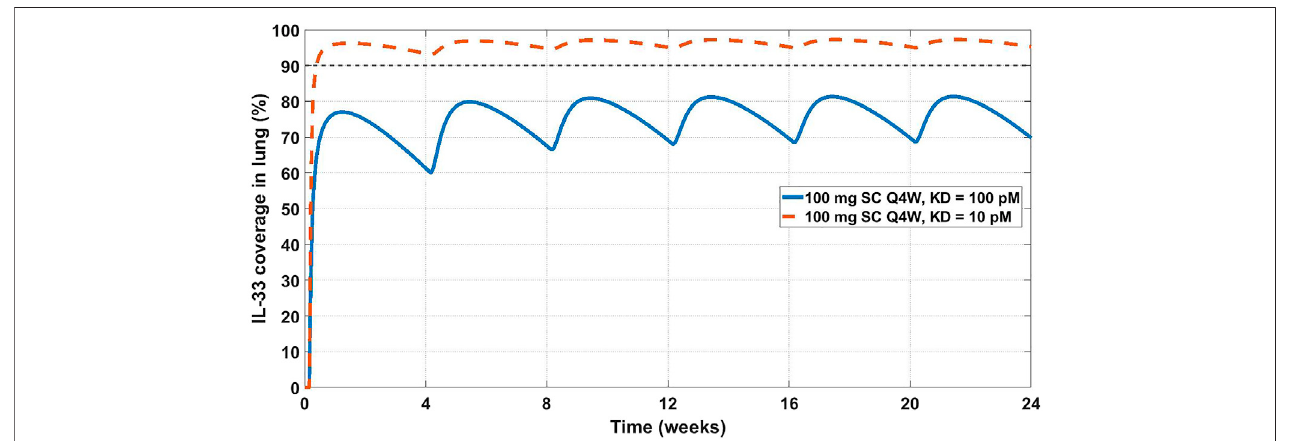
FIGURE5| Projected IL-33neutralizationinthelungat100 mgSCQ4Wdosingat10pM(dashedorangeline)and100pM (solidblueline)drugaf fi nities.The90% coverage line (dashed grey) is emphasized for convenience. The model projects that a 10 pM af fi nity would achieve 90% IL-33 neutralization in the lung.